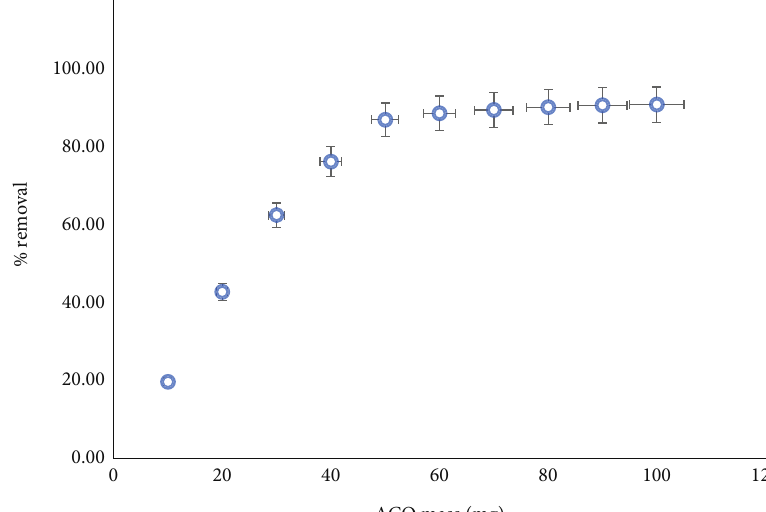
= 50 mg : L − 1 ; pH = 7 : 0 , sonication i